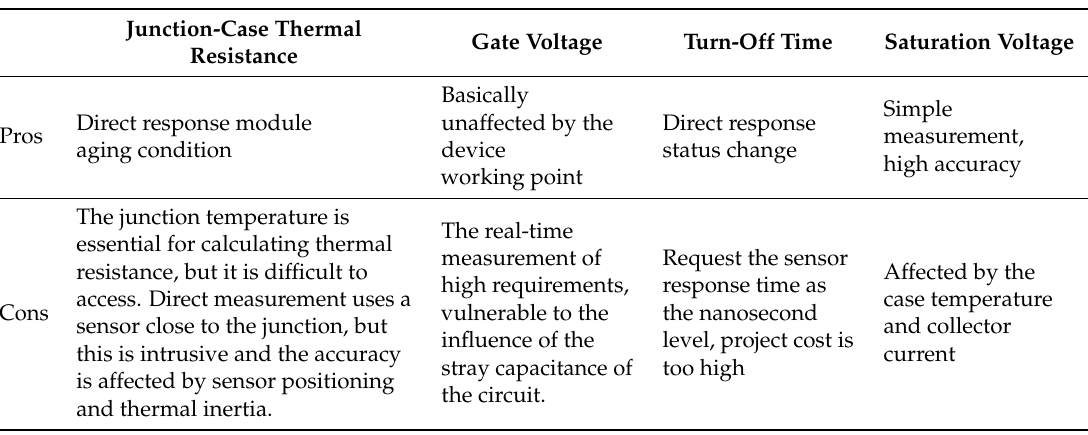
Table 2. Pros and cons of the four characteristic